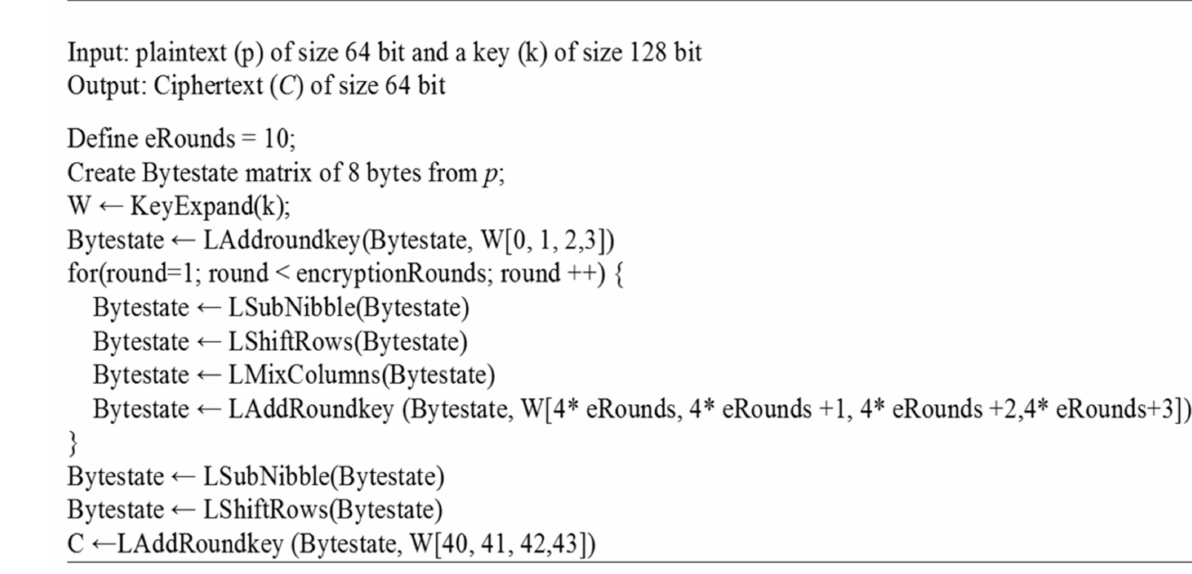
Figure 2. Encryption process of LAES